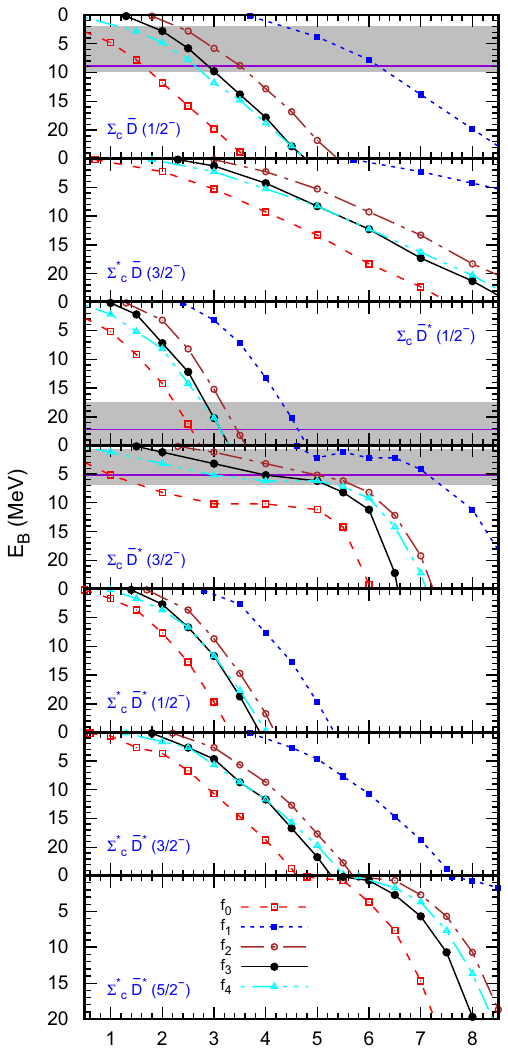
Fig. 1 Thebindingenergy E B withthevariationofthe α forisodoublet bound states from the single-channel interaction. The thresholds M th for the Σ c ¯ D , Σ ∗ c ¯ D and Σ ∗ c ¯ D ∗ channels are 4320.8, 4385.3, 4462.2 and 4526.7 MeV, respectively. The f i with i = 0 , 1 , 2 , 3 , 4 means the results without form factor for exchanged meson or with form factor f i ( q 2 ) in Eqs. (11–14), respectively. The horizontal lines and the bands are the experimental mass and uncertainties observed at LHCb [1] ¯ D with 1 / 2 − . With reasonable with 1 / 2 − and 3 / 2 − , and Λ c ¯ D ∗ parameters, no bound state can be produced from the Λ c ¯ D interactions.Forotherseveninteractions,thebound and Λ c states are produced in the range of the α considered in the current calculation. Here, the results with different types of form factors for exchanged meson are presented in Fig. 1. The results show that the different choices of the form factors change the quantitive results but the qualitative conclusion are not changed. Moreover, the order of the curves for dif- ferent form factors are almost the same for the seven bound states. It indicates that if appropriate cutoffs are adopted,